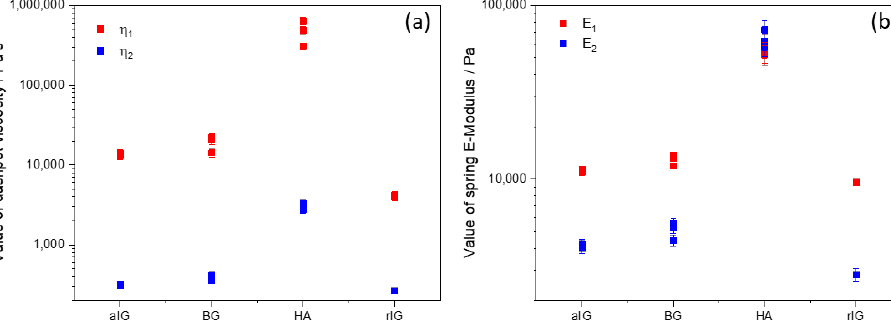
Figure 7. Resulting model parameters for the augmented Burgers model for dashpot viscosity ( a ) and spring Young’s modulus ( b ) for the different investigated inks. 2.7. Printability and Shape Fidelity: Semi-Quantitative Analysis For the semi-quantitative analysis of the printing behavior, rectangular grids and res- olution trees were generated to investigate the influence of the used fillers on the printing performance. Grids with rectangular pores were used for accuracy measurements, includ- ing the material’s ability to stay stable in its printed dimension, even if a second layer is printed on top of the first, without shape distortion. Light microscopy images of the printed grids and resolution tress are shown in Figure 8. Further inspection of the printed grids revealed that no phase separation or sedimentation of the filler particles during the composite material fabrication has taken place. Since rheological characterization re- vealed a relatively high viscosity, such segregation had not been expected.